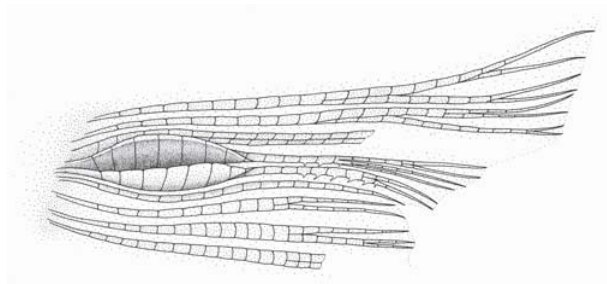
Fig. 49. Mimagoniates pulcher , developing male, MNRJ 4233, 37.0 mm SL; pelvic-fin rays, ventral view, left